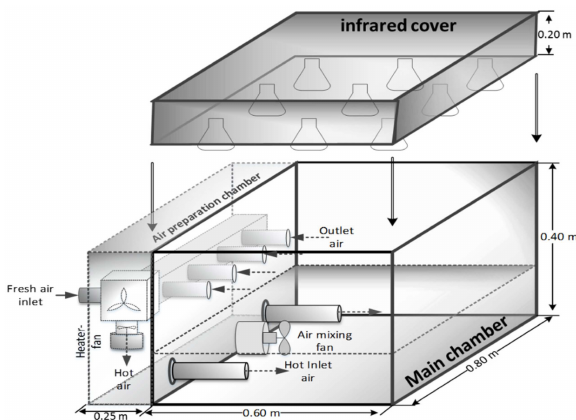
Figure 1. Schematicrepresentationoftheexperimentalincubatorshowingthemainchamber,airpreparation chamber, and the infrared